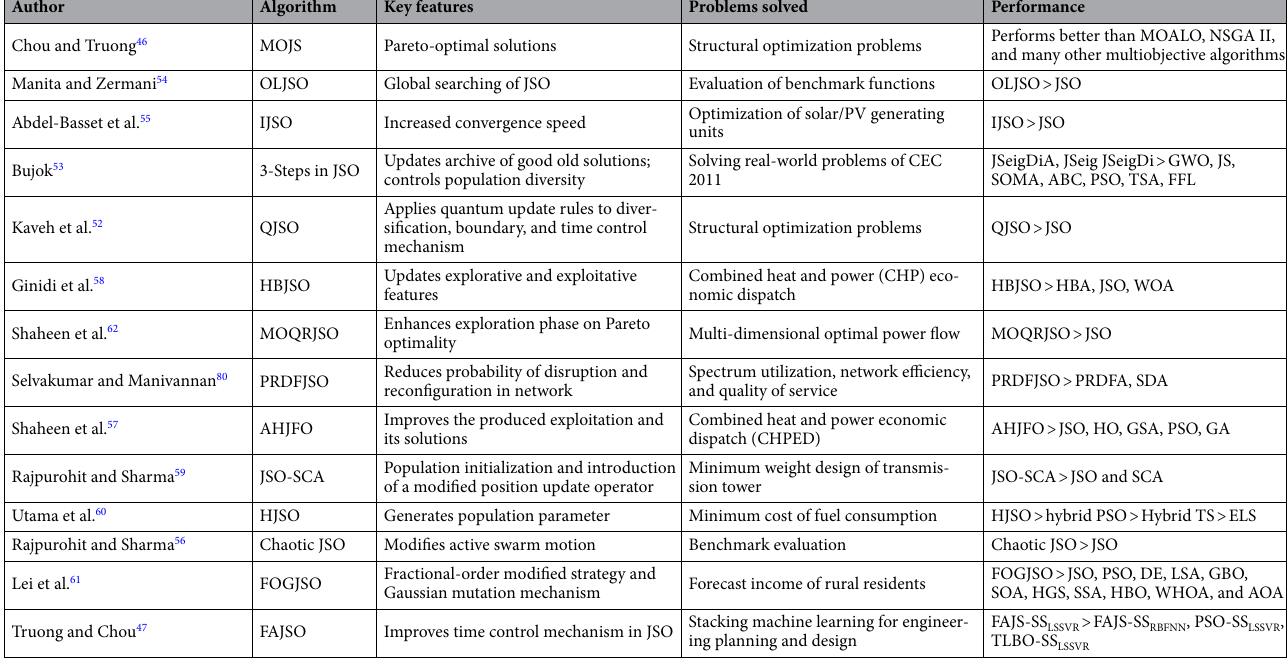
Table 4. Comparative analysis of variants and hybrids of